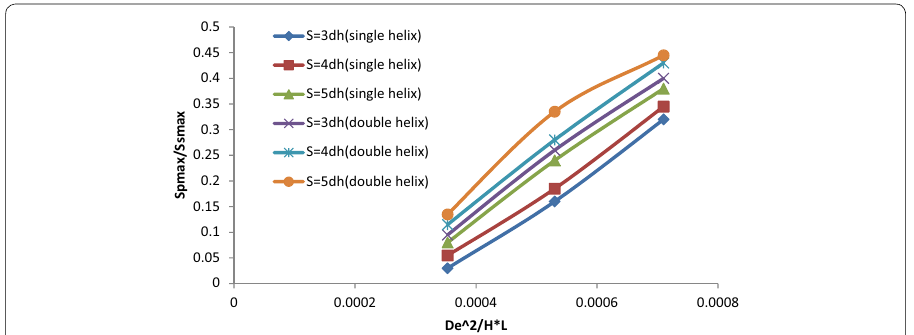
Fig. 34 Design charts for a group of four helical piles with single and double helix